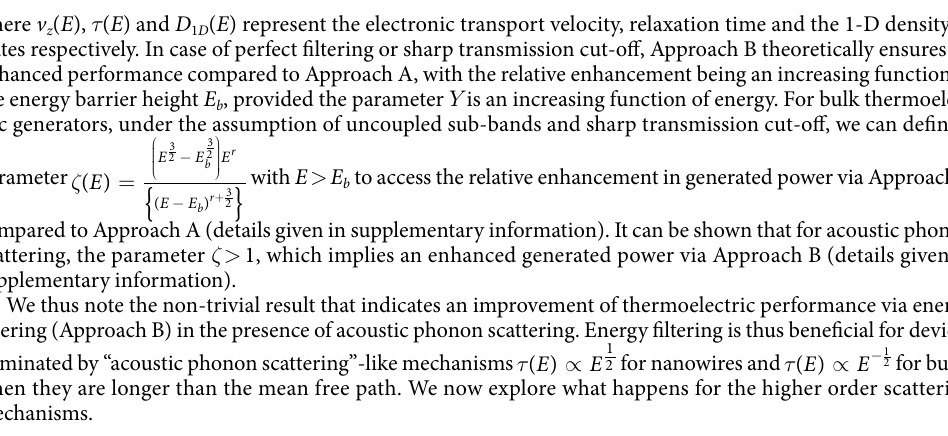
Figure 2. Analysis of energy filtering in the ballistic case. ( a , d ) Analysis for a 20 nm long and 2.7 nm × 2.7 nm ballistic square nanowire: ( a ) Power-efficiency trade-off analysis in case of Approach A for various values of E c . ( b , c ) Power-efficiency trade-off analysis in case of Approach B for various values of η = µ + − η = µ − f k T B = 1.35 nm , E = 150 meV ), ( c ) with thick barrier ( σ w b ( d ) Plot of filtering coefficient ( λ ) versus efficiency ( η / η C ) for a thin, a thick and a perfect energy filtering barrier. ( e – h ) Analysis for a 20 nm long bulk generator: ( e ) Power-efficiency trade-off analysis in case of Approach A for E c various values of η = µ − . ( f – g ) Power-efficiency trade-off analysis in case of Approach B for various values f k T B E c of η = µ − ( f ) with thin barrier ( σ w = 1.35 nm , E b = 150 meV ), ( g ) with a thick barrier ( σ w = 2.7 nm , f k T B E b = 150 meV ) ( h ) Plot of filtering coefficient ( λ ) versus efficiency ( η / η C ) for the bulk generator in case of a thin, a thick and a perfect energy filtering